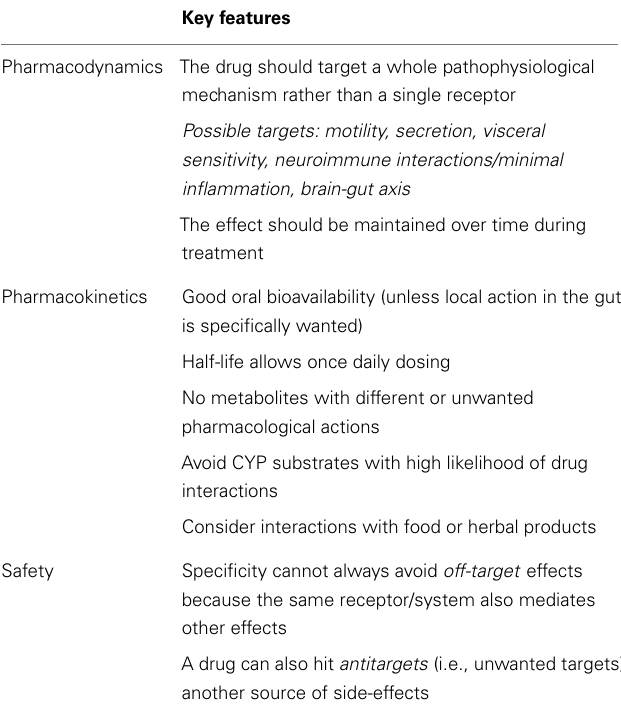
Table 1 | Key features for drugs to be used in the treatment of